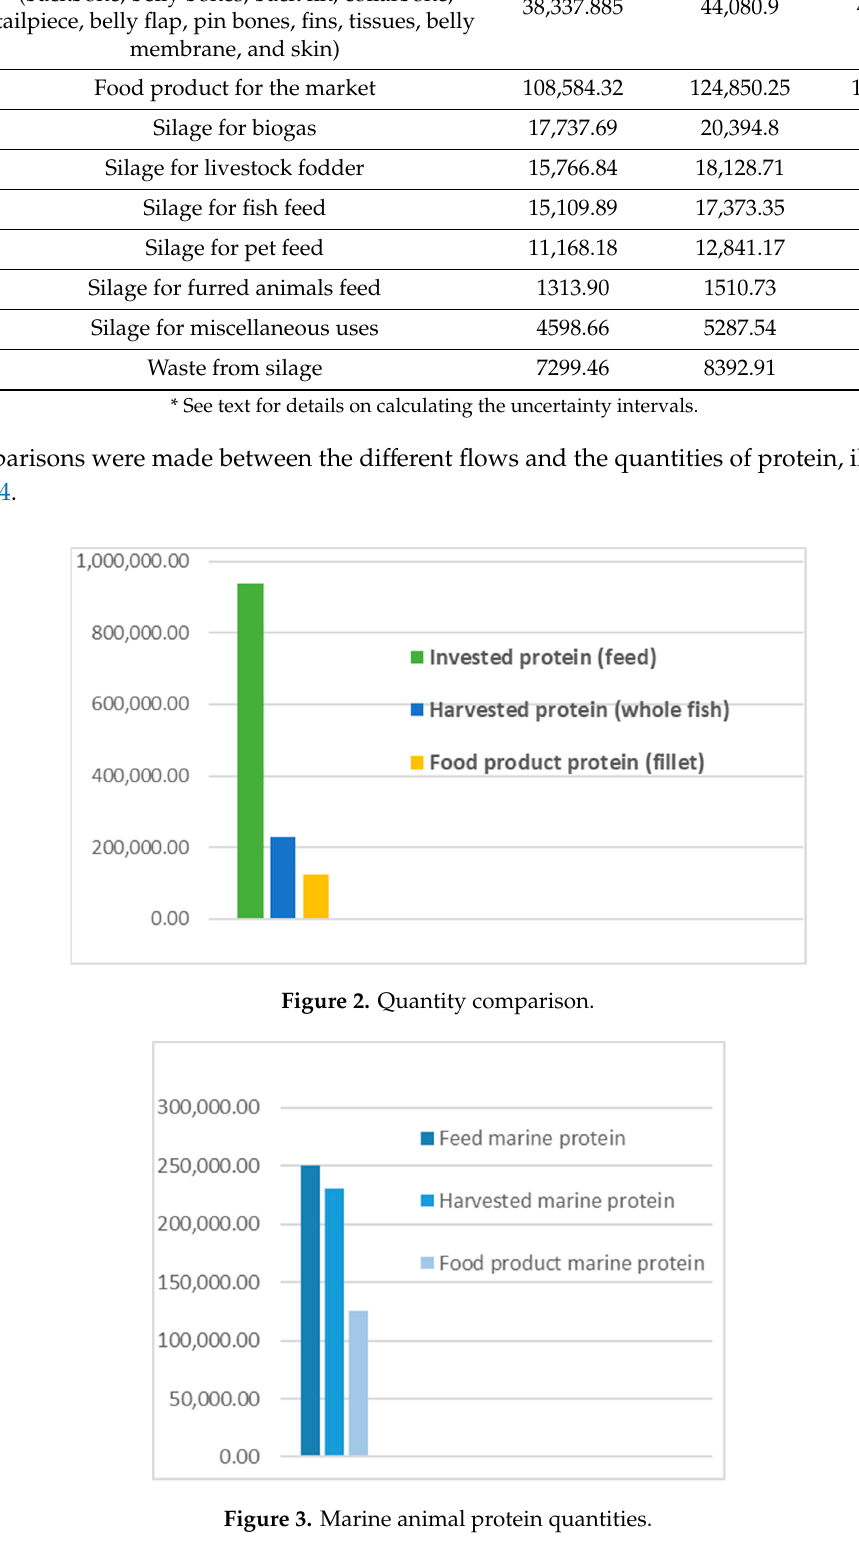
Figure 4. Post-harvest protein distribution. 3.2. Alternative Scenario An alternative scenario was developed on the basis of conserving the harvested salmon protein and its holding biomass into the human food chain. This scenario limits all post-harvest flows into food production (Figure 5), presenting a need for a parallel food product B to be developed. Material trade-offs with pet food and biogas industries still exist, but in a different sequence. The change in the protein quantities in different flows suggested by this scenario illustrated in Figure 6 and Figure 7.